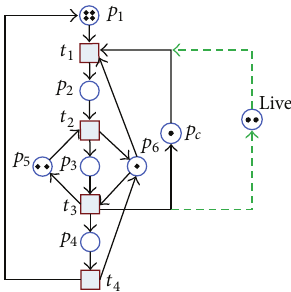
Figure 2: A controlled system (𝑁 𝑐 ,𝑀 𝑐 ) for (𝑁,𝑀 0 ) .